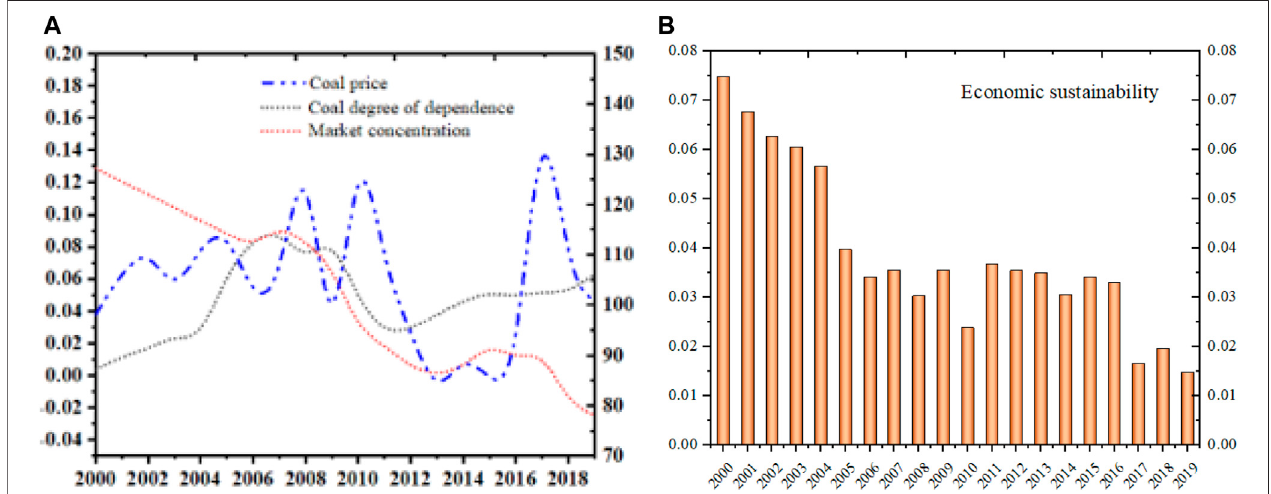
FIGURE 5 | Economic sustainability results from 2000 to 2019: (A) indicator value; (B) dimension value.